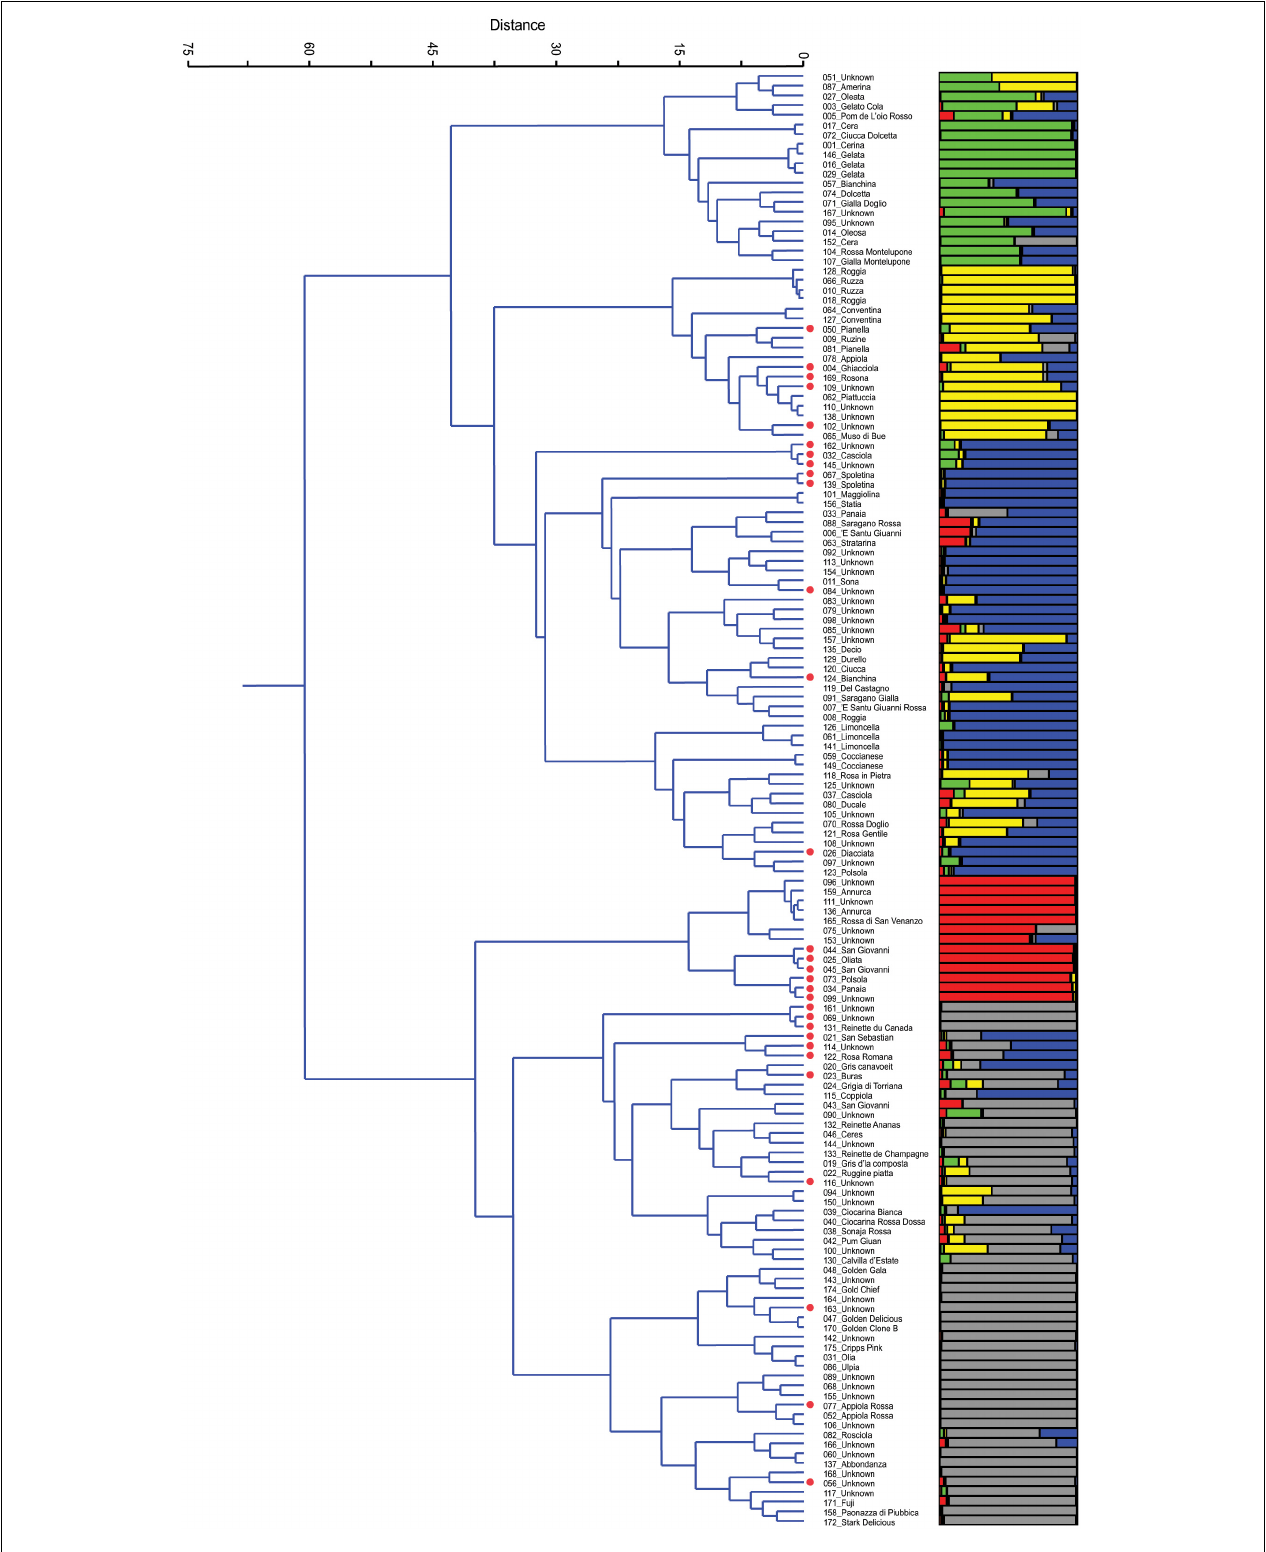
FIGURE 1 | Ward’s clustering dendrogram of the 150 accessions of apple (on the left) and assignment by STRUCTURE at K = 5 (on the right). Polyploids are red labelled beside the accession name.